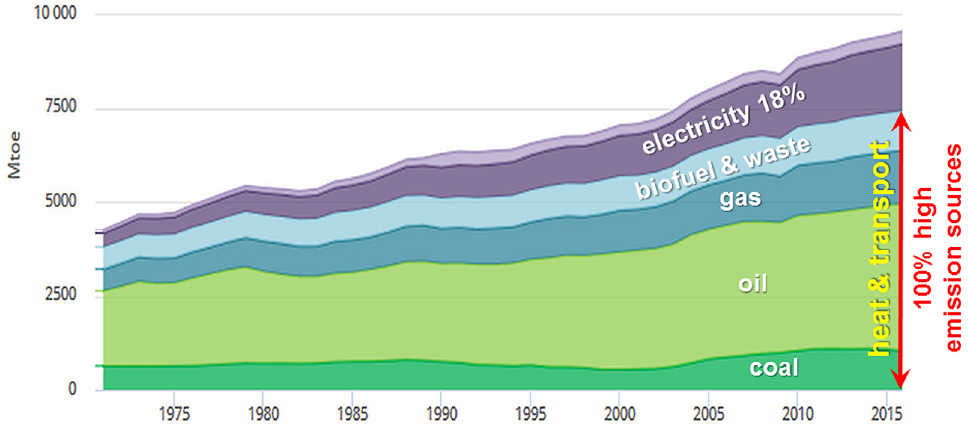
Fig. 1. World energy consumption by source (Adapted from [1]).